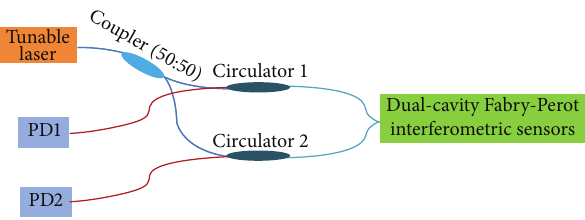
Figure 4: Experimental setup for driving optical devices of dual- cavity fiber Fabry-Perot interferometer.